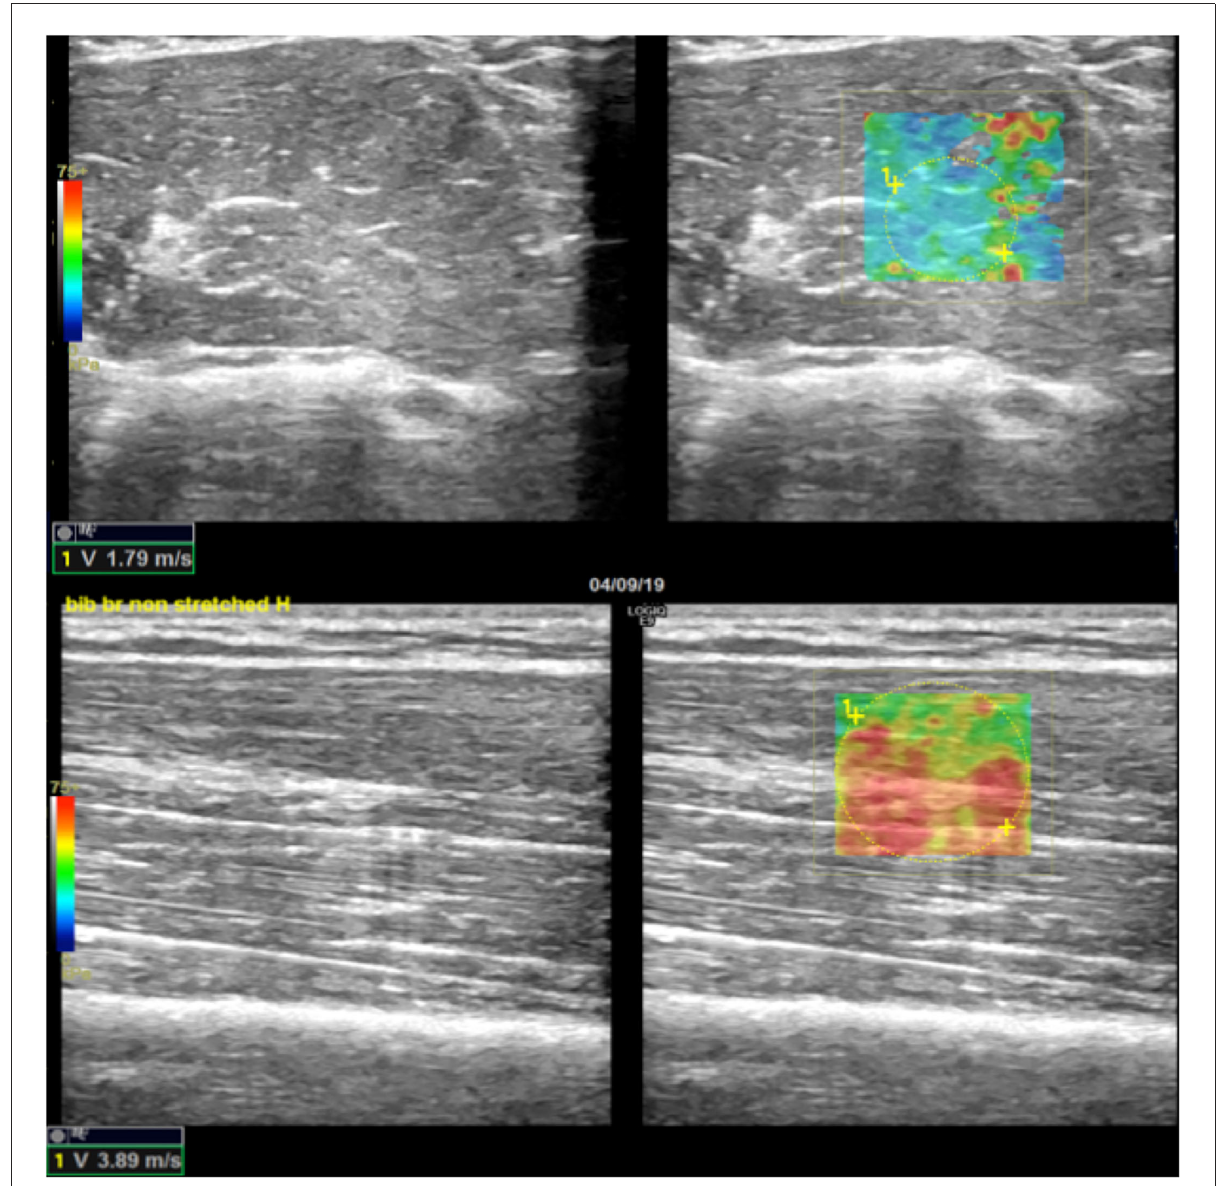
FIGURE7 Example of SWE difference between axial and longitudinal assessments. In the upper-right quadrant is illustrated an example of an elastogram (superimposed to the B-mode image) generated by an ROI placed in a non-paretic, shortened biceps brachii muscular belly across the direction of the fibers; in the lower right image, the elastogram generated along the direction of muscular fibers of the same muscle shows higher values expressed both qualitatively with different-colored map and quantitatively in m/s (lower left corners of the images). Images on the upper- and lower-left quadrant are the respective B-mode conventional US image automatically paired on the screen by the SEL software (axial US scan in the upper-left quadrant and longitudinal US scan in the lower-left